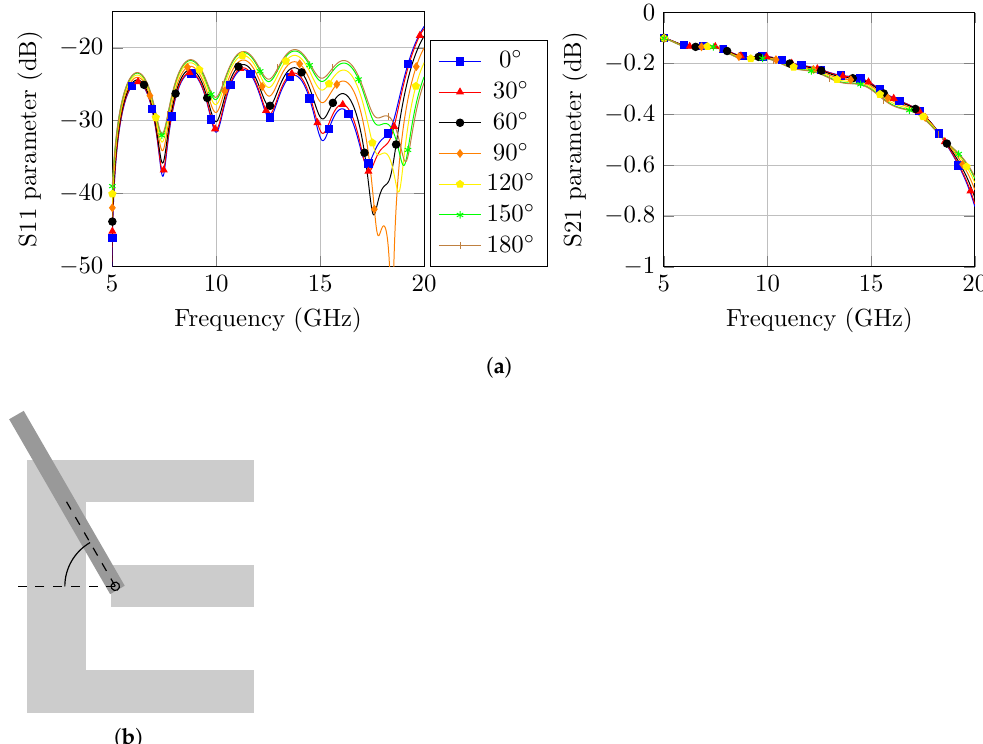
Figure 8. Influence of the feeding line angle: ( a ) results for the scattering parameters depending on the feeding angle; and ( b ) definition of angle.